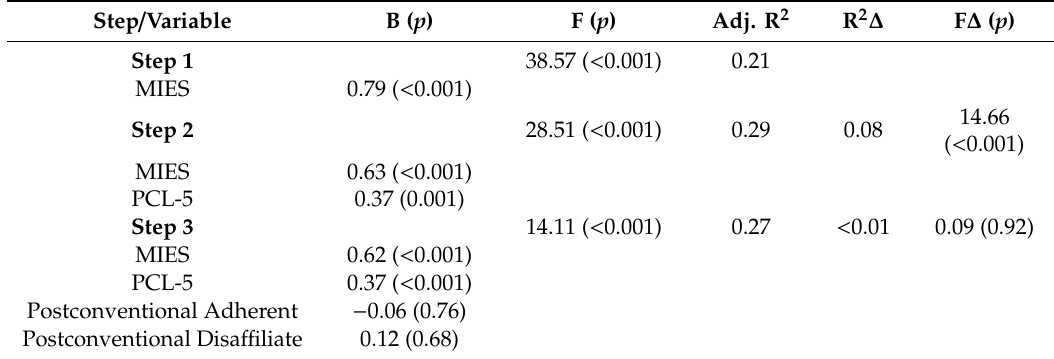
Table 3. Exposure to Potentially Morally Injurious Events, PTSD Symptoms, and MMPSF postconventional subscales as predictors of Moral Injury Questionnaire